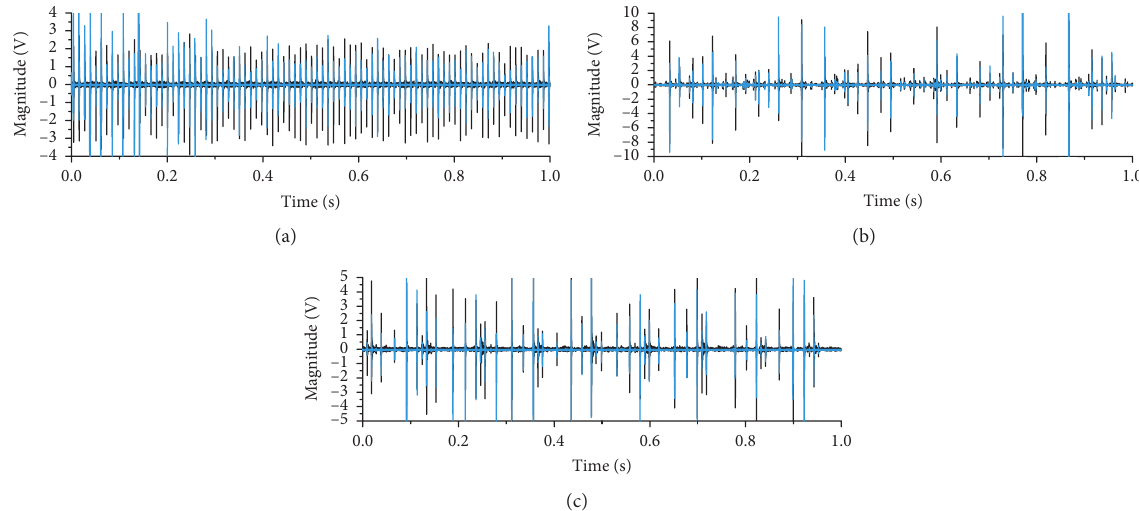
Figure 8: Results of the proposed method (blue line) and the original vibration signals (black line) of REBs. Bearings with a point defect on (a) outer race; (b) inner race; (c) rolling element.